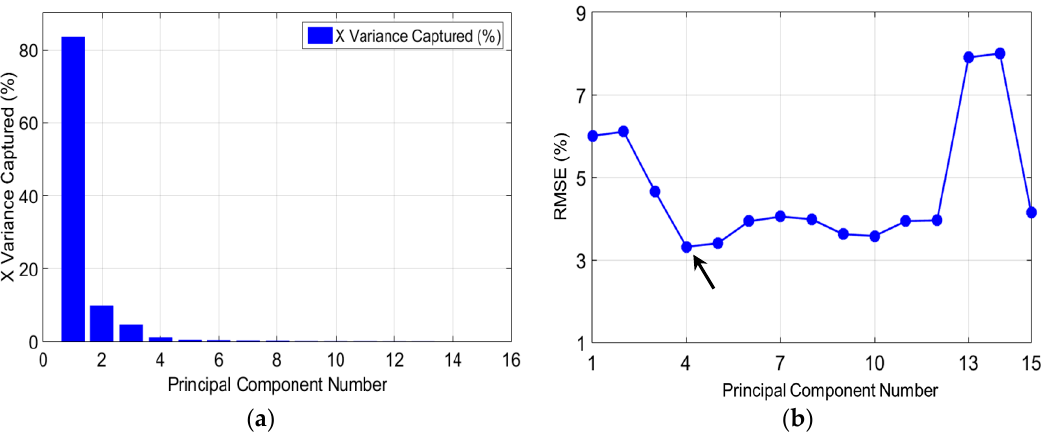
Figure 6. Example cross-validation method for optimizing a partial least squares (PLS) model: ( a ) Plot for the X-variance captured by the model; ( b ) Plot of latent variables (LVs) vs. root-mean-square error (RMSE) (the arrow indicates the optimized LVs with the lowest root-mean-square current (RMSC)).